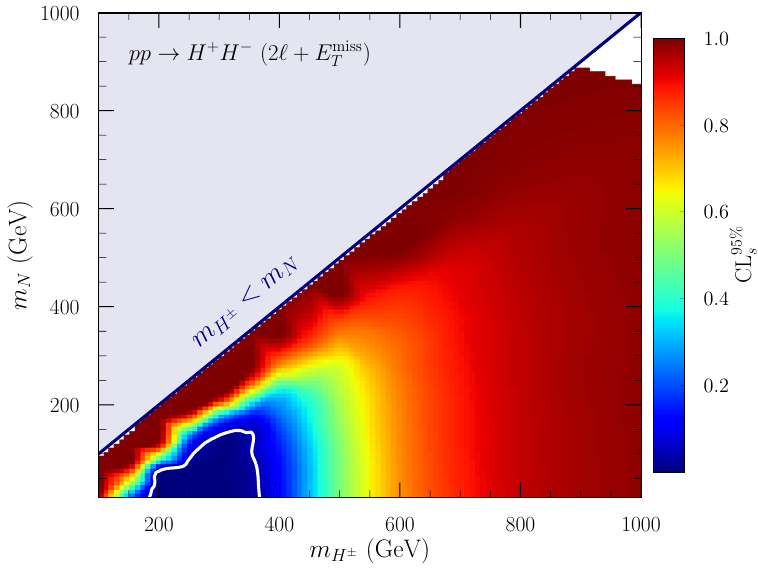
√ Figure 2 . The LHC exclusions from slepton searches at s = 13 TeV and L = 139 fb − 1 . The limits are projected on the mass of the charged Higgs and the mass of the Majorana DM. The white solid line corresponds to CL = 0 . 05 below which the parameter point is excluded at the 95% s